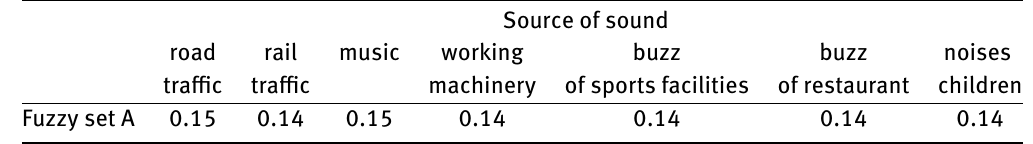
Table 1: Fuzzy set of "The impact of sound sources of noise in the park".